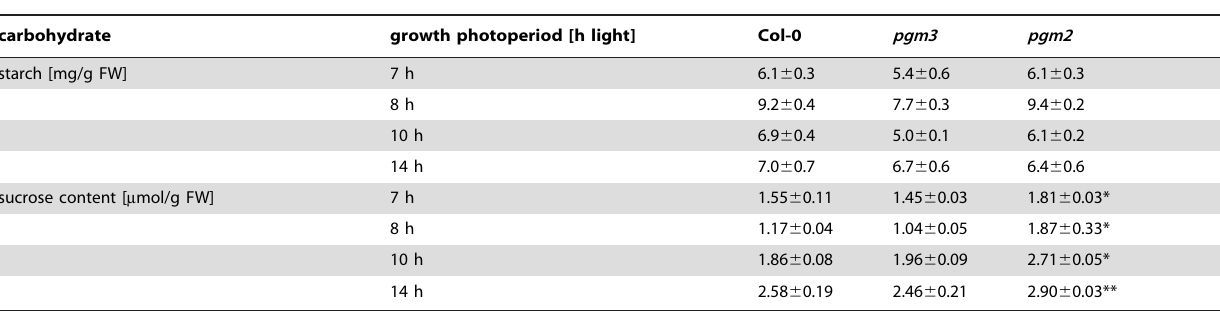
Table 1. Carbohydrate content.